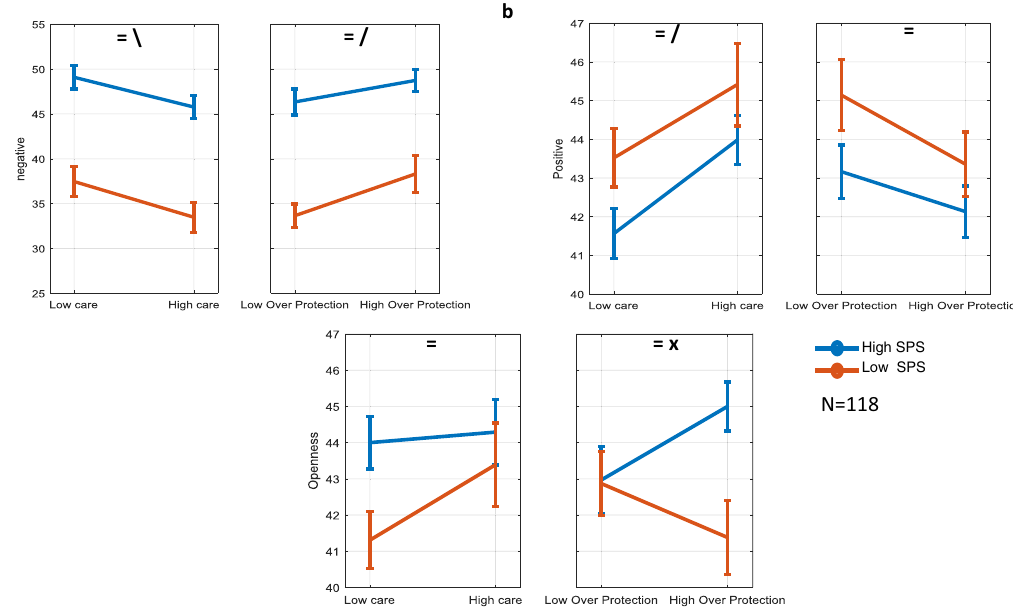
Figure 6. Effect of SPS and PBI (care and overprotection) on average scores of negative and positive clusters and on openness scores. ( a ) Negative trait score: main effect of SPS F 1,114 > 58.87, p < 0.0, main effect of care F 1,114 = 5.95, p = 0.01, SPS x care interaction F 1,114 = 0.06, p = 0.80, main effect of overprotection F 1,114 = 5.56, p = 0.02, SPS x overprotection interaction F 1,114 = 0.59, p = 0.44, ( b ) positive trait score: main effect of SPS F 1,114 > 4.01, p < 0.04, main effect of care F 1,114 = 7.96, p = 0.005, SPS x care interaction F 1,114 = 0.09, p = 0.76, main effect of overprotection F 1,114 = 3.36, p = 0.06, SPS x overprotection interaction F 1,114 = 0.27 , p = 0.60, ( c ) openness score using the original 27-item HSPS: main effect of SPS F 1,114 > 0.74, p < 0.05, main effect of care F 1,114 = 1.7, p = 0.19, SPS x care interaction F 1,114 = 0.97, p = 0.32, main effect of overprotection F 1,114 = 0.09, p = 0.76, SPS x overprotection interaction F 1,114 = 3.9, p = 0.05. = , significant main effect of SPS, \ significant main effect of parental care or overprotection, x significant